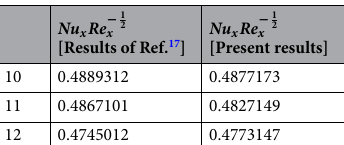
Table 5. Comparison of the present work with the published work 17